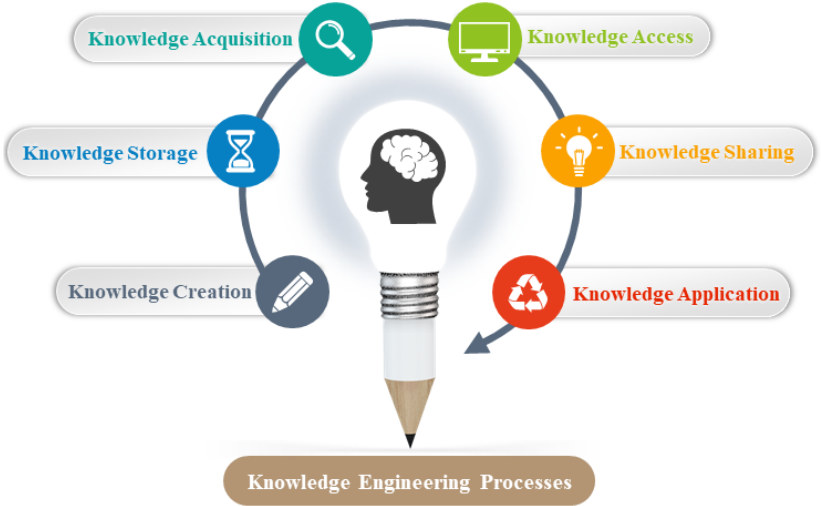
Fig. 2. Knowledge Engineering